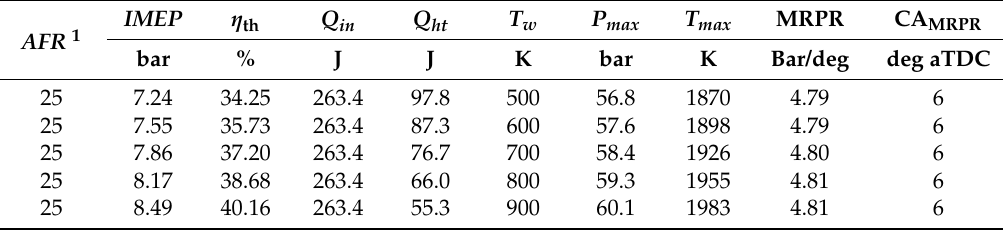
Table A2. Effects of wall temperature on the simulated results for combustion pattern 2. AFR 1